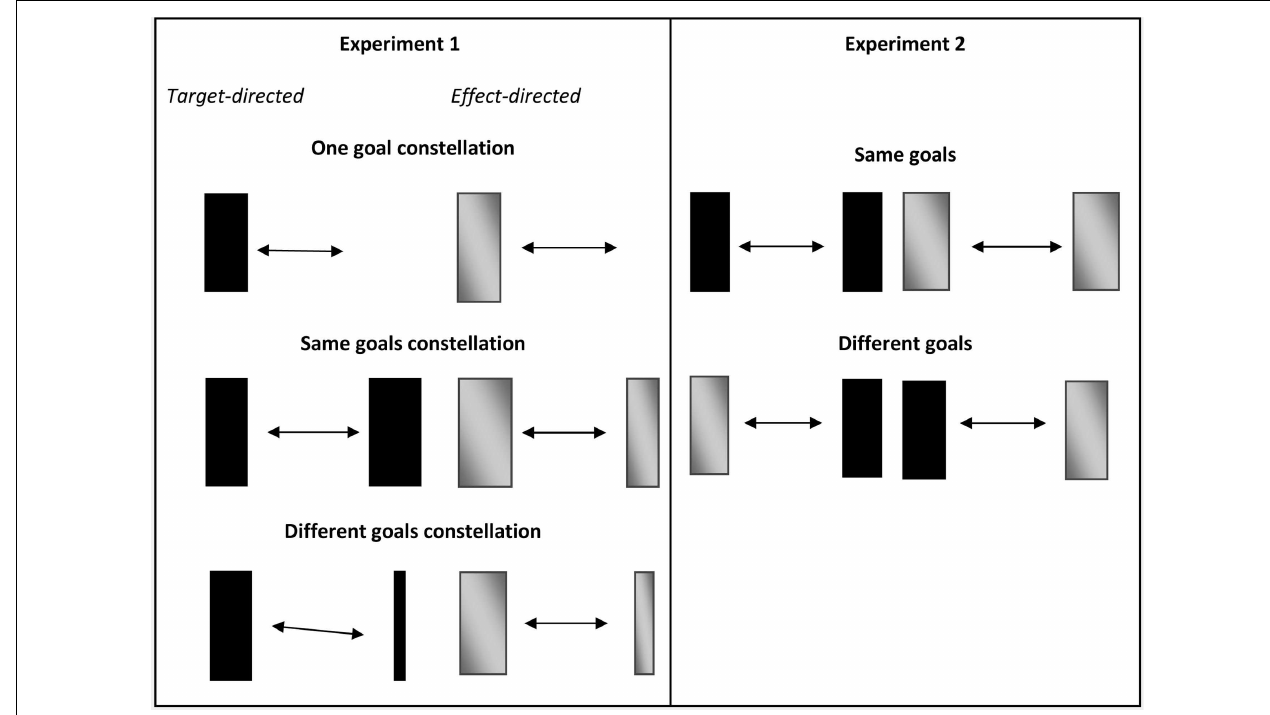
target-directed movements participants were asked to reverse their movements within constantly presented black boxes, while in effect-directed movements such boxes were self-produced as they only appeared whenever participants reached the x -position of the inner edge of the to-be-produced